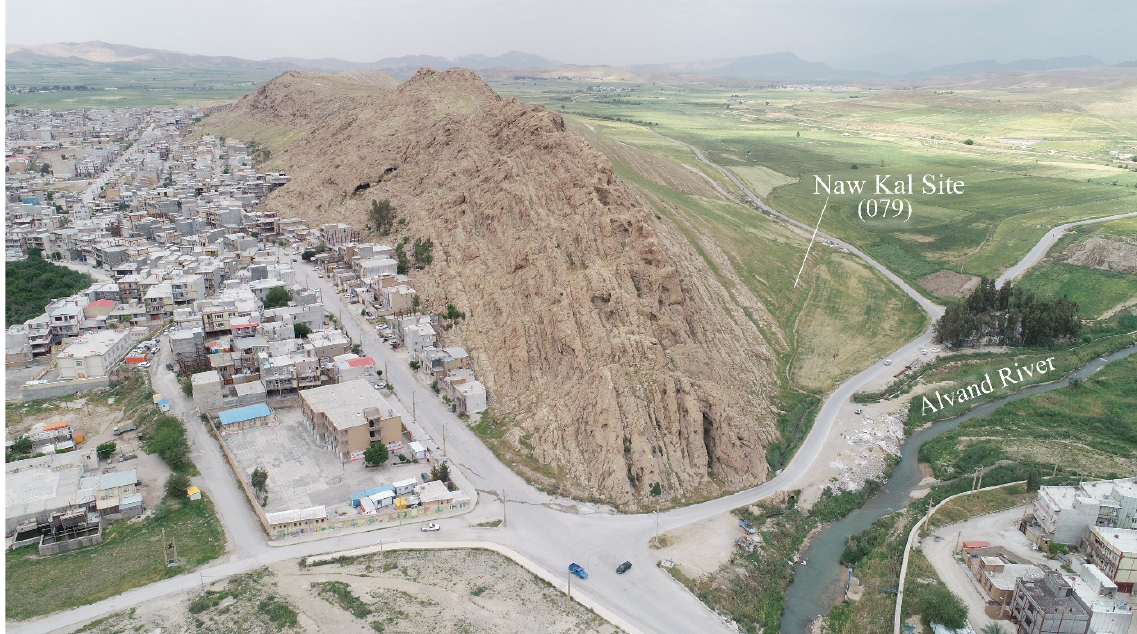
Figure 10. A view of Naw Kal showing the location of its rock mortar (courtesy of Reza